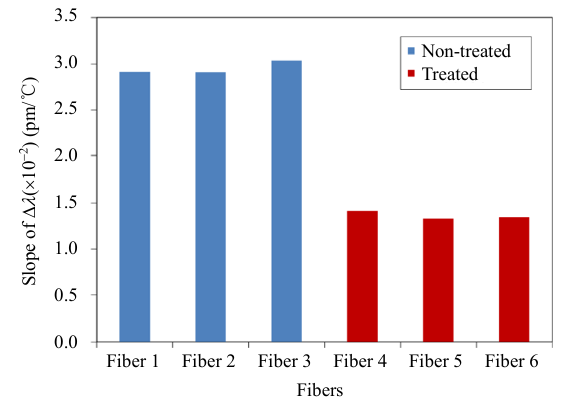
Fig. 6 Comparison of the slope value of Δ  for the treated fibers and non-treated fibers during thermal regeneration